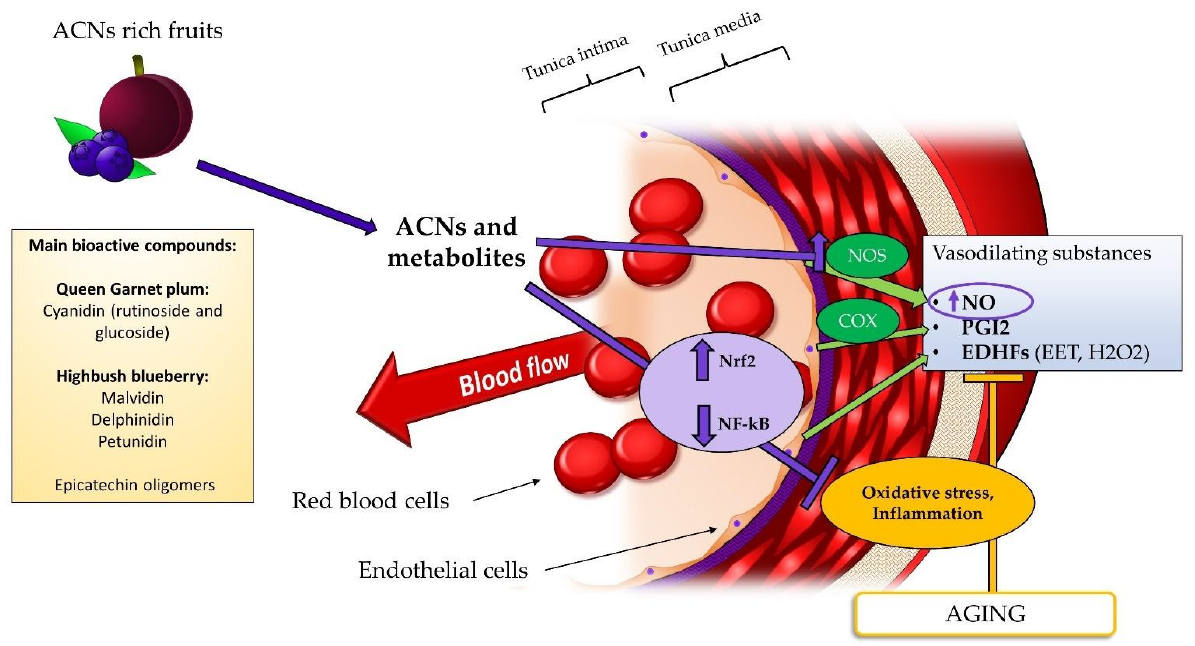
Figure 3. Schematic representation of the mechanism of action supposed for ACNs rich fruits in the increase of vascular function in the elderly. In contrast to nitrates that act by increasing NO levels through NOS-independent pathways, ACNs increase the expression of NOS and counteract the detrimental effects of oxidative stress (due to activation of Nrf2, that lead to increased defense from ROS) and inflammation (inhibiting the activation of NF-kB), thus increasing NO production and contribute to the restoration of its availability. Legend: ACNs, anthocyanins; COX, cyclooxygenase; EDHFs, endothelial derived hyperpolarizing factors EET, epoxyeicosatrienoic acid; H 2 O 2 , hydrogen peroxide; NF-kB, nuclear factor kappa B; NO, nitric oxide; NOS, nitric oxide synthase; Nrf2, nuclear receptor factor 2; PGI2, prostacyclin 2.